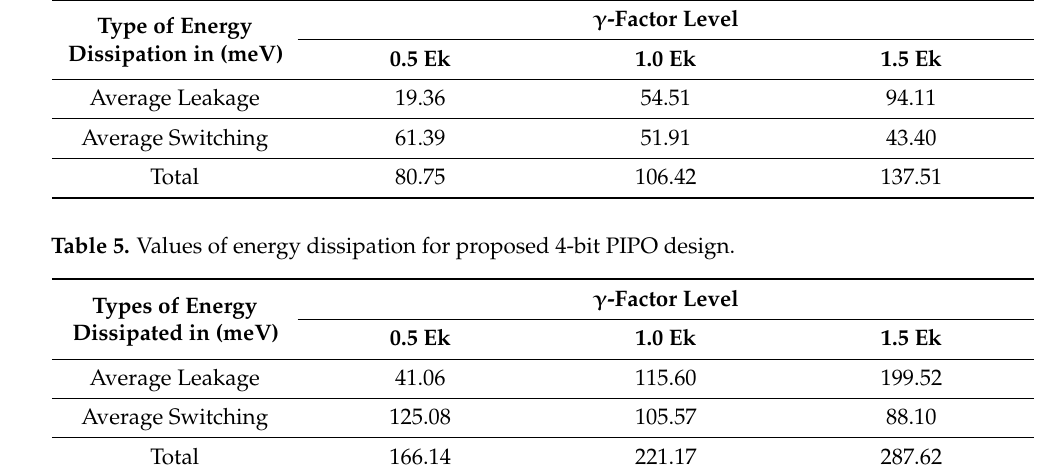
Table 5. Values of energy dissipation for proposed 4-bit PIPO design.